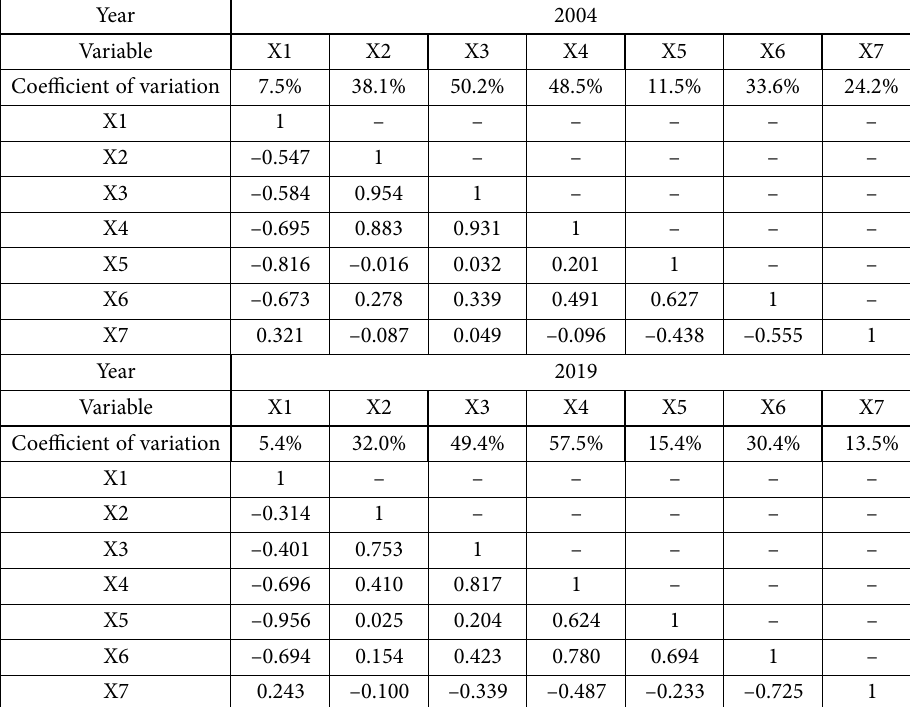
Table 3. Values of coefficients of variation and correlation matrix between diagnostic variables (2004,